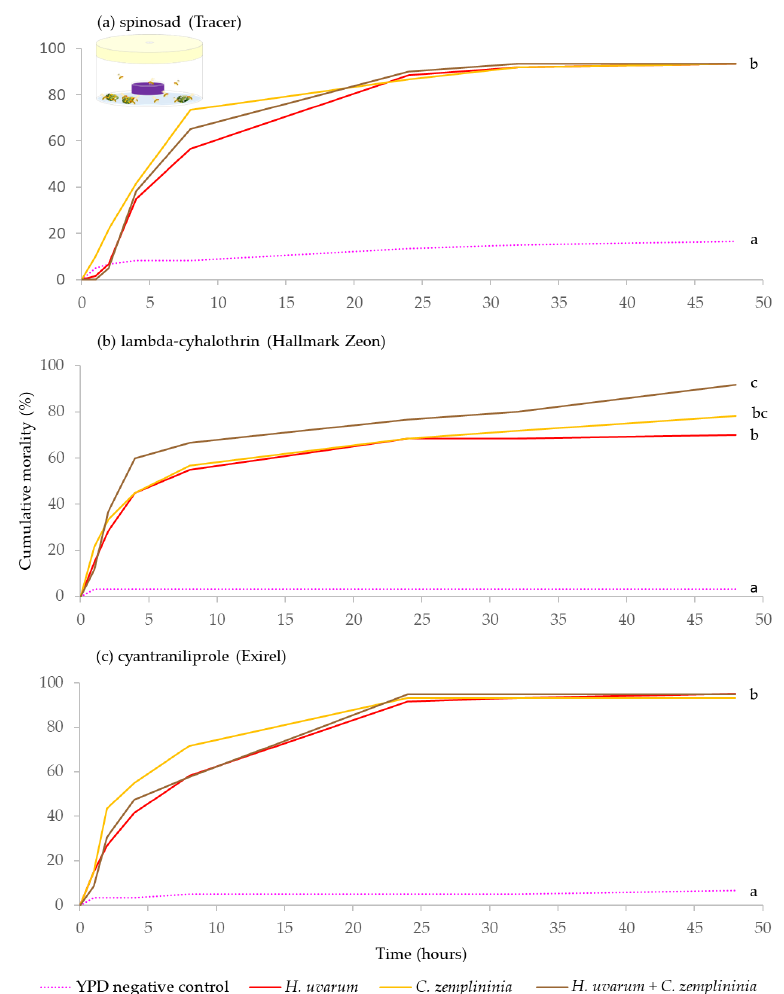
Figure 2. Cumulative percentage mortality of winter-morph D. suzukii exposed to yeast phagostimulant baits ( H. uvarum , C. zemplininia and H. uvarum + C. zemplininia ) in combination with the insecticides ( a ) spinosad, ( b ) lambda-cyhalothrin or ( c ) cyantraniliprole, compared to YPD media (negative control, dotted line). Experiments lasted 48 h, conditions inside the jars were 22.4 °C and 92.7% humidity with 16:8 h light: dark photoperiod. Separate log -Rank Pairwise comparisons for each insecticide were used to determine significance between treatment and different letters at the ends of lines denote significance differences (within each insecticide, p < 0.05).